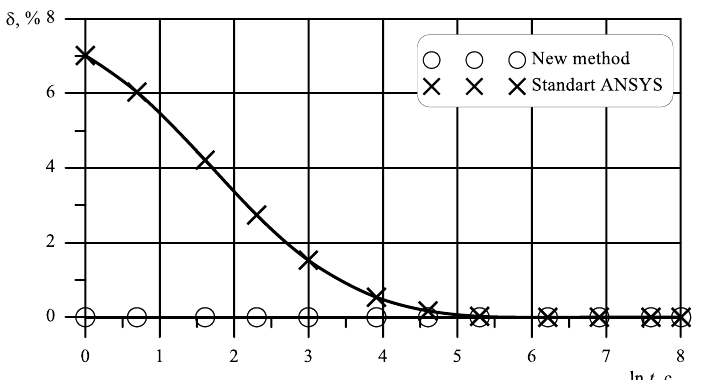
Fig. 2. The relative discrepancy of solutions of the problem of stretching, obtained by different methods with respect to the analytical method